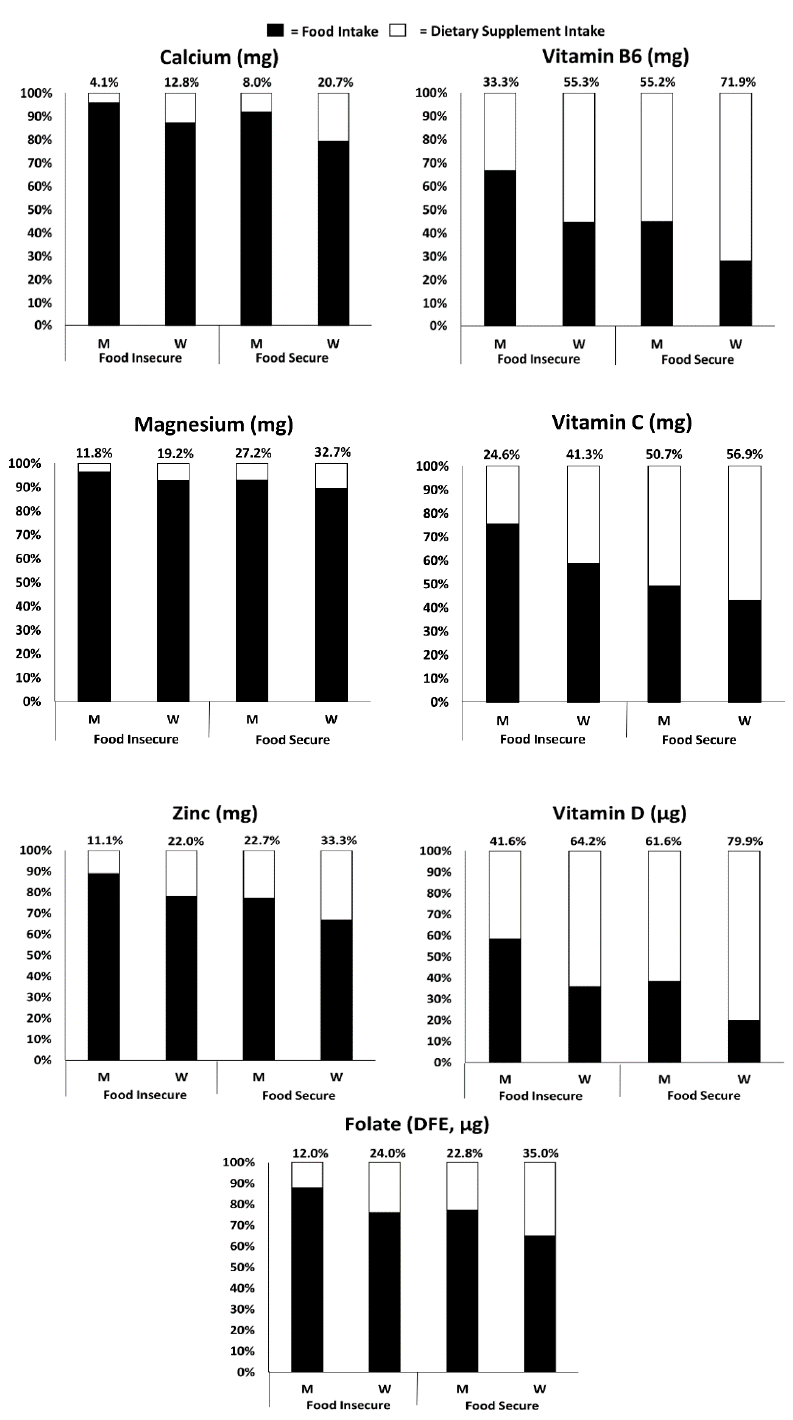
Figure 1. Relative contribution of foods / beverages and dietary supplements to total usual intakes for selected nutrients by age group among men and women by food security status ( ≥ 19 years) in the U.S., 2011–2014. 1 ( 1 The analytic sample includes individuals ≥ 19 years old that were not pregnant or lactating with complete information for food security and the day 1 and 2, 24 h dietary recalls. Percentages above each bar represent the relative contribution from dietary supplements). Abbreviations: M, Men; W, Women; DFE, Dietary Folate